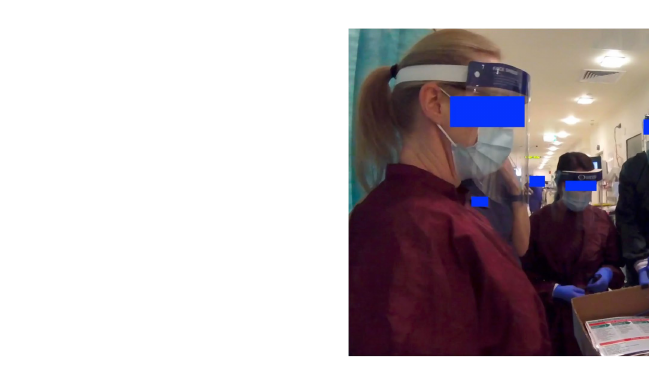
FIGURE 2 Photo of simulated planning by group 3 (From left to right N7, N8, N9, D6,